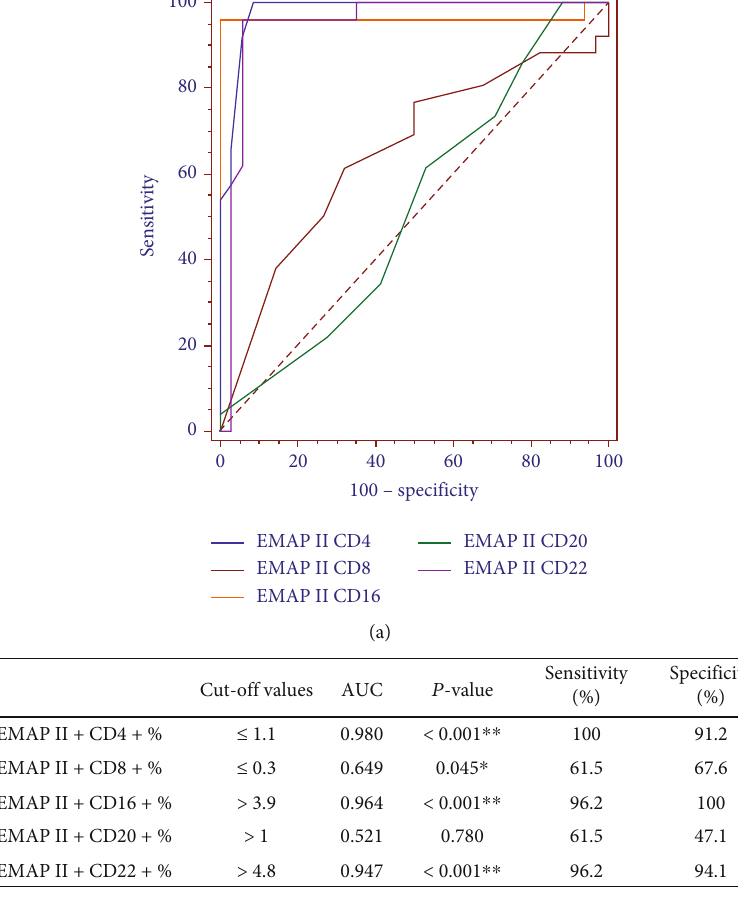
Figure 5: Diagnostic performances of percentages of EMAP II+CD4, EMAP II+CD8+, EMAP II+CD16+, EMAP II+CD20+, and EMAP II +CD22+ for identifying NHL patients with recurrence. (a) ROC curves were gained by curves at di ff erent cut-o ff s for NHL patients. (b) AUC (area under the curve) with cut-o ff s, sensitivity, and speci fi city for the markers. Signi fi cance ( P < 0 : 05 ) is identi fi ed with ∗ . High statistical signi fi cance ( P < 0 : 001 ) is identi fi ed with ∗∗